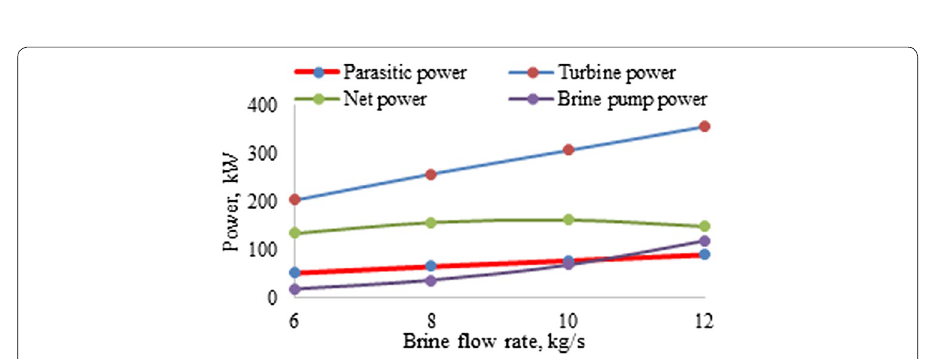
Fig. 9 Net power development vs brine flow rate